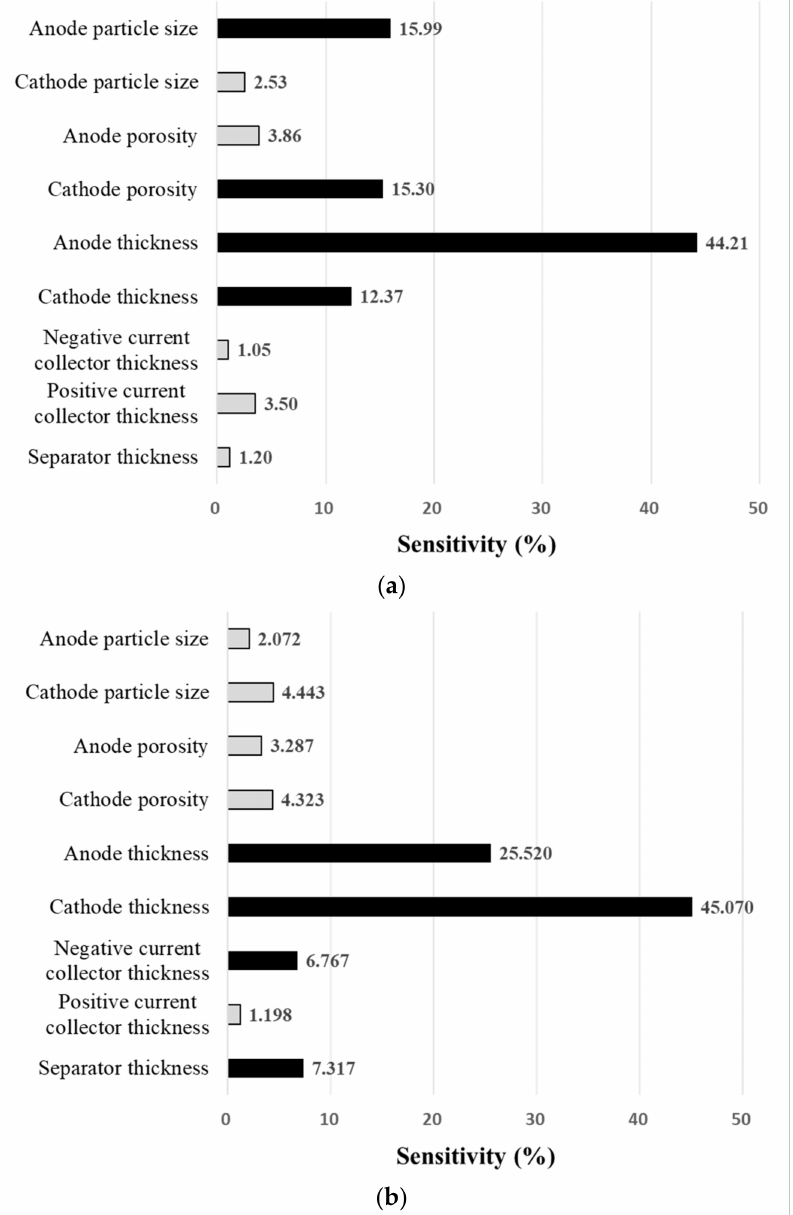
Figure 3. Sensitivity results for design factors sensitive to ( a ) energy density and ( b ) power